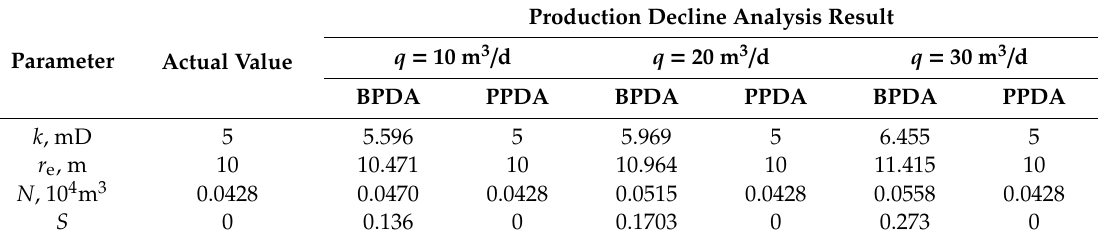
Figure 17. Match of production data for CRP case of q = 30 m 3 /d. Table 6. Comparison between the results obtained by BPDA and PPDA for CRP cases.